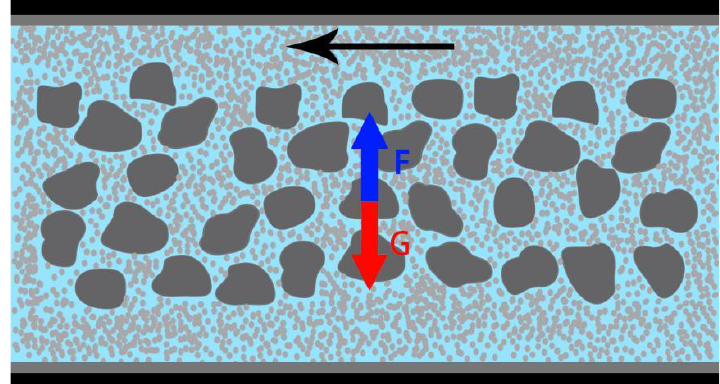
Figure 13. Aggregate stress in the structural flow of the transportation mode.